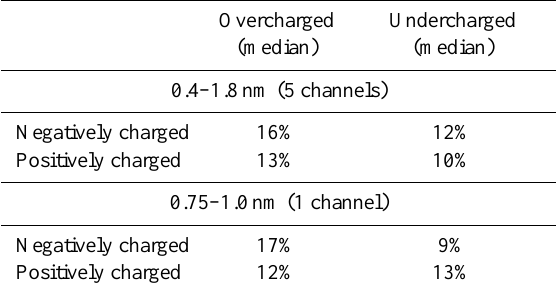
Table 1. The fraction of small particles removed from the pool of charged nanoparticles during new particle formation events. The calculations are based on the medians of all days as they appear in Fig. 5. The dip is always bigger for overcharged days: in concen- trations for all 4 categories (size range and polarity), and in percent- age for 3 out of 4. The difference is more important for negatively charged particles. Fraction of charged nanoparticles removed from their